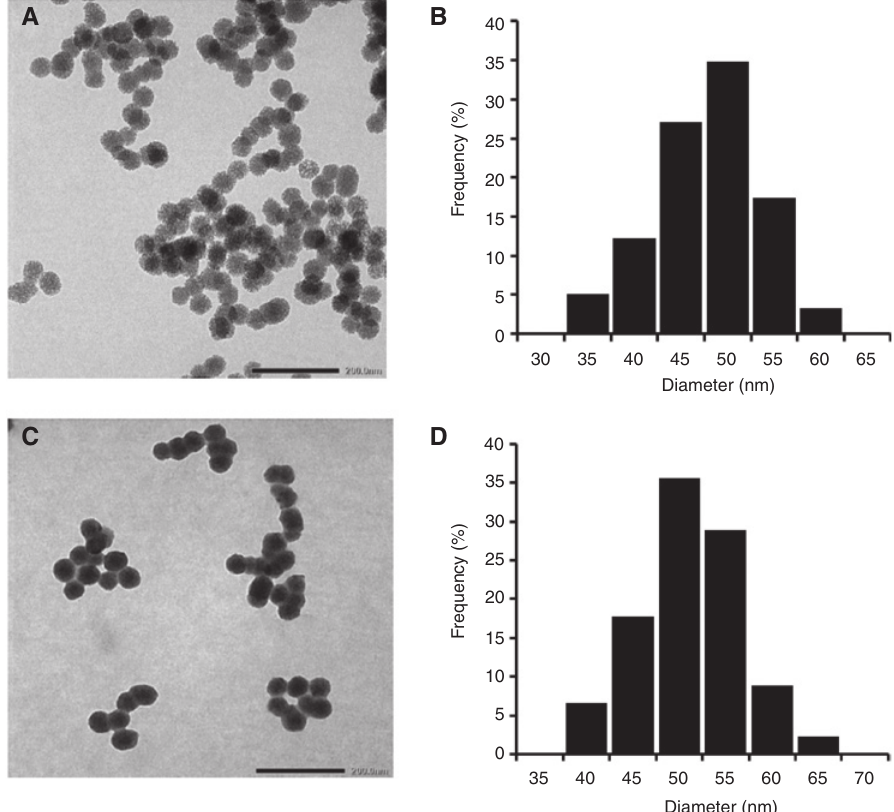
Figure 5: (A, C) Transmission electron microscopy (TEM) micrographs and (B, D) size distributions of porous nanosilica (PNS) (A, B) and adamantylamine-polyethylene glycol-functioned cyclodextrin-porous nanosilica (PNSC@APEG) (C, D).